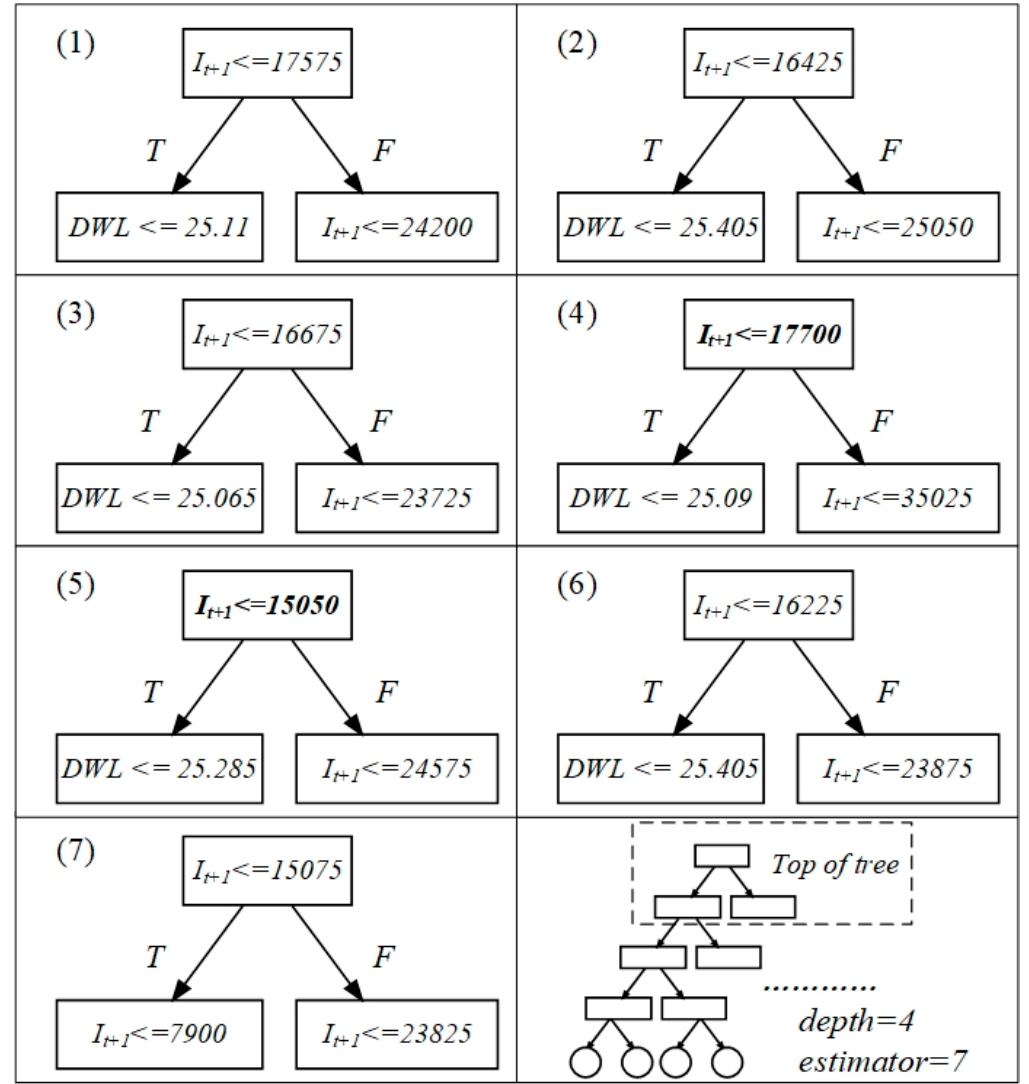
Figure 7. The top of seven decision trees in the outflow simulation model of scenario 4.